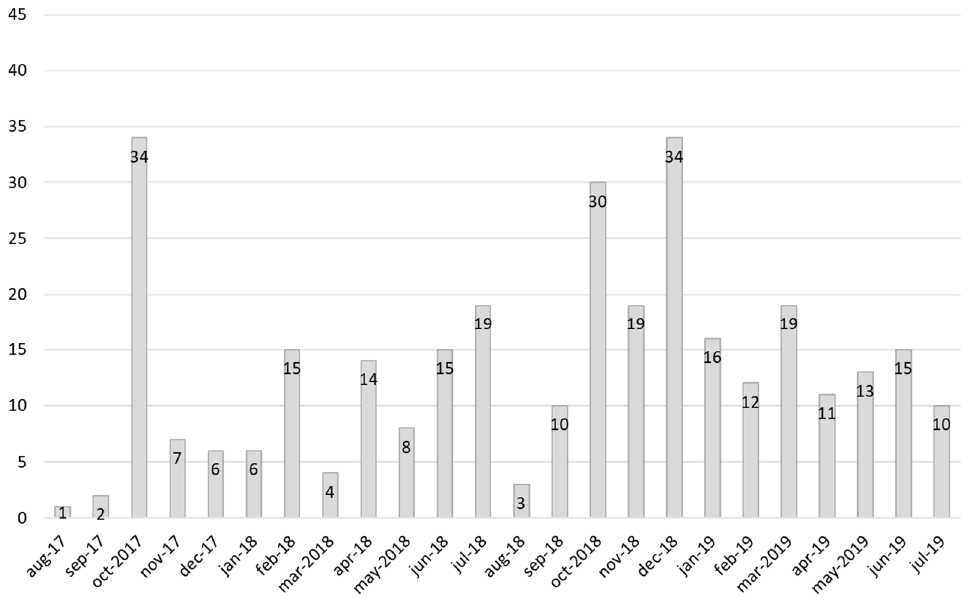
Figure 1. The number of articles published about CCS in the Netherlands during the investigated period. The majority of the articles were news articles ( n = 228, 70.4%) or opinion pieces ( n = 60, 18.5%). Interviews ( n = 22, 6.8%), letters from readers ( n = 4, 1.2%), and other types ( n = 10, 3.1%) made up the remaining